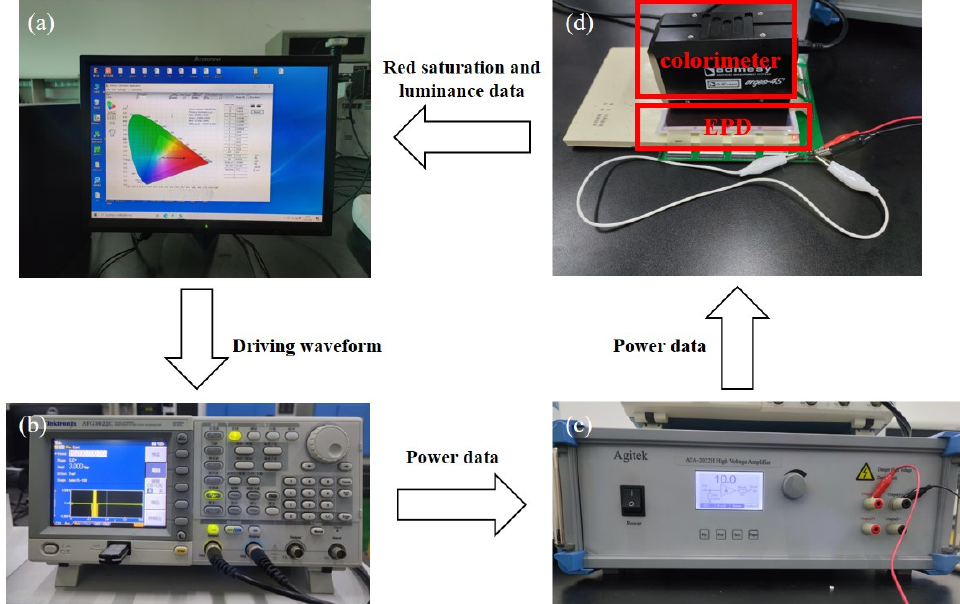
Figure 2. The experimental platform for three-color EPDs. ( a ) A computer. ( b ) A function generator. ( c ) A voltage amplifier. ( d ) A colorimeter and a three-color EPD. The driving waveform was edited in the computer. Then, an edited driving waveform was imported into the function generator, and then power data from the function generator was amplified by the voltage amplifier. Next, the three-color EPD was driven by power from the voltage amplifier, red saturation and luminance data of the three-color EPD were collected by the colorimeter. Finally, the data were transmitted to the